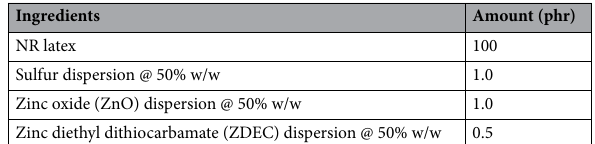
Table 1. Formulation of the pre-vulcanized natural rubber (PNR) latex.